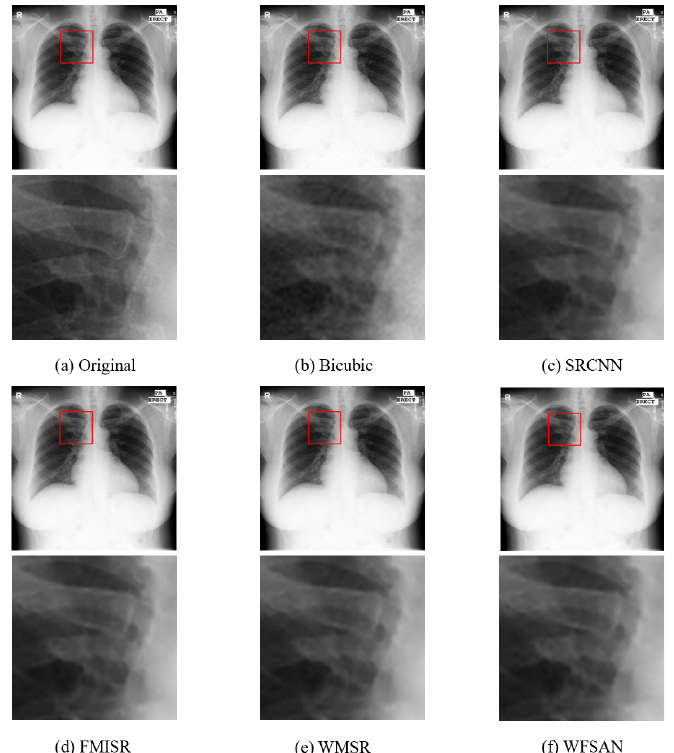
Figure 10. Visual comparison of different models in MontgomerySet normal chest dataset, ( a ) Original(HR) image, ( b ) Bicubic, ( c ) SRCNN, ( d ) FMISR, ( e ) WMSR, ( f )